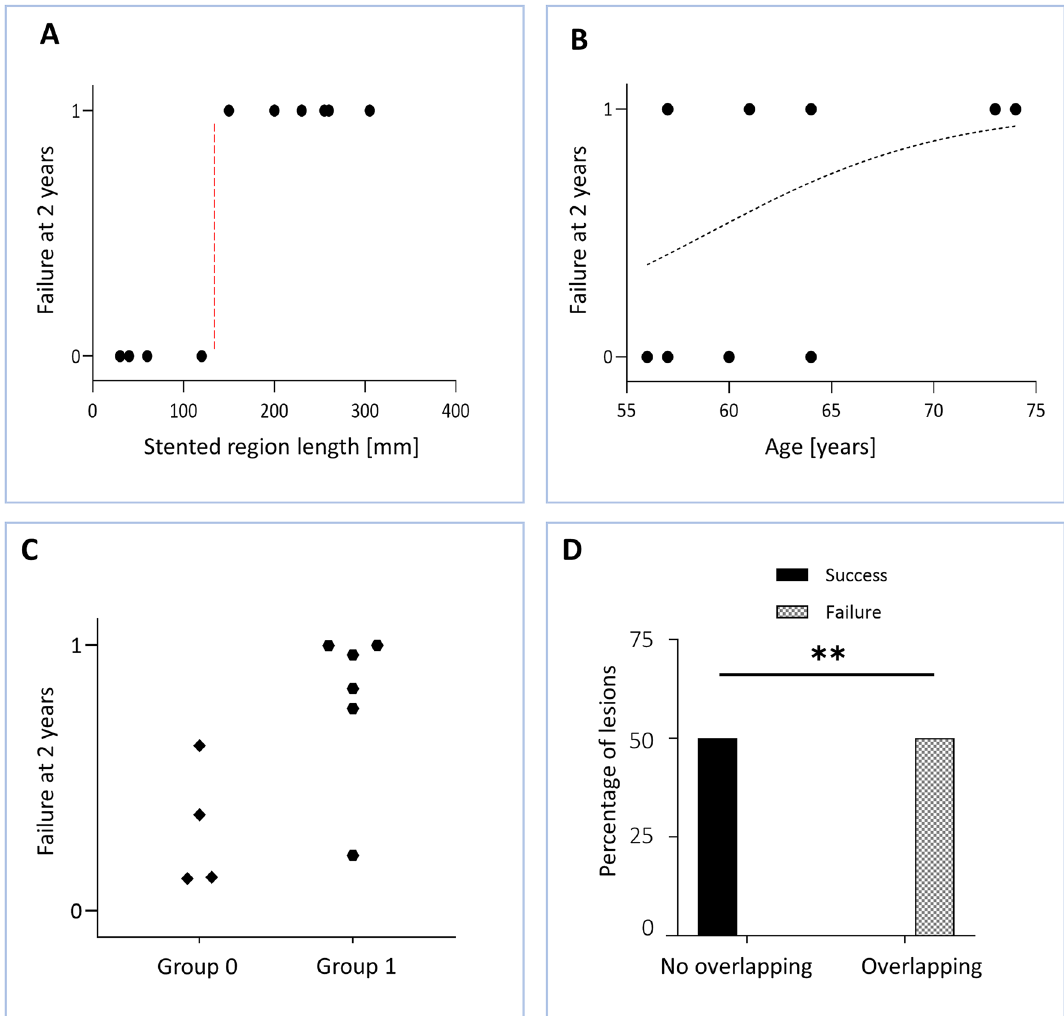
Figure 4. Results of the logistic regressions. ( A ) Simple logistic regression between stented region length and failure at 2-year follow-up. ( B ) Simple logistic regression between age and failure at 2-year follow-up. The dotted line represents the predicted probability of failure. ( C ) Multiple logistic regression between the hemodynamic descriptors (time-averaged wall shear stress, oscillatory shear index and relative residence time), and the predicted probability of failure at 2-year follow-up. ( D ) Result of the Fisher’s exact test that was performed to compare the dichotomous variables stent overlapping and outcome at 2-year follow-up. **p < 0.01.